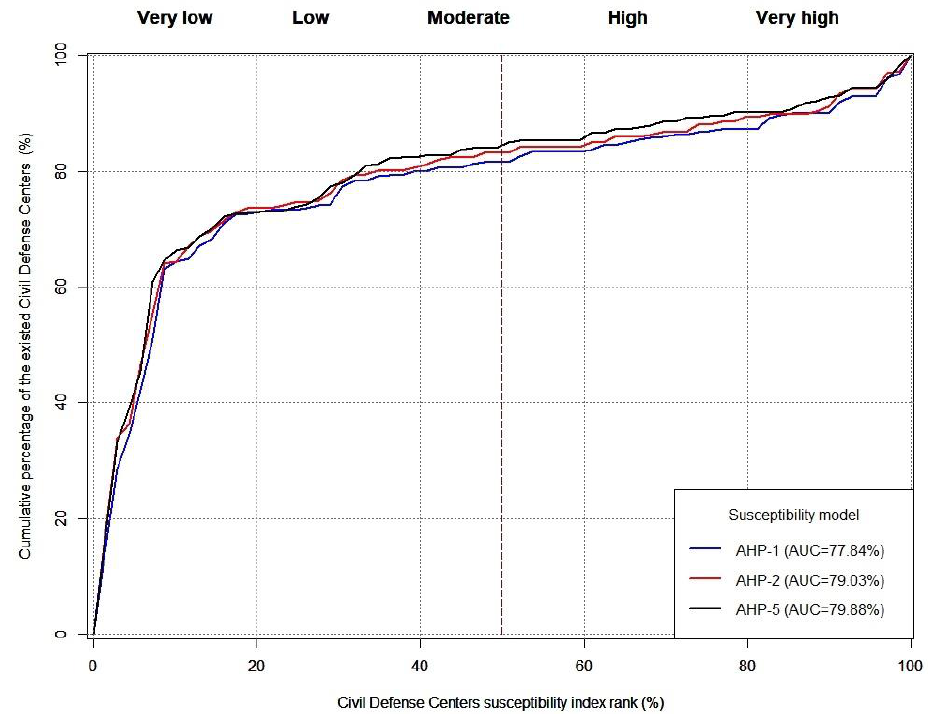
Figure 8. PRC plot evaluation of the three best CDC models after adding the existing CDC factor.